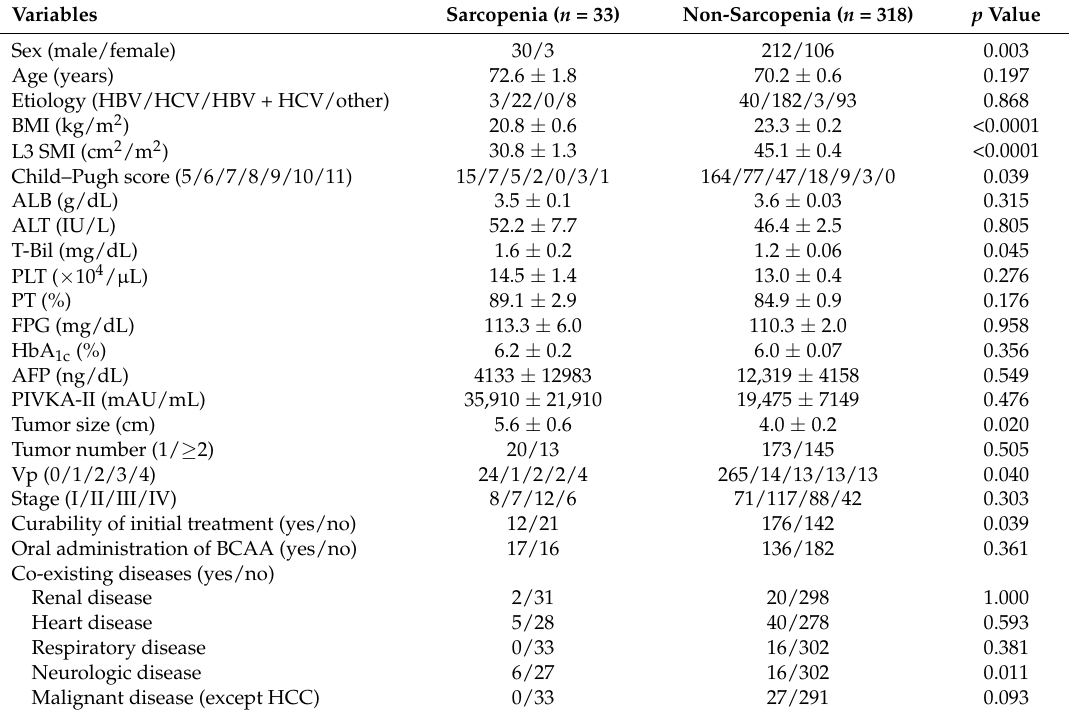
Table 2. Baseline demographic and clinical characteristics of sarcopenia and non-sarcopenia groups. Variables